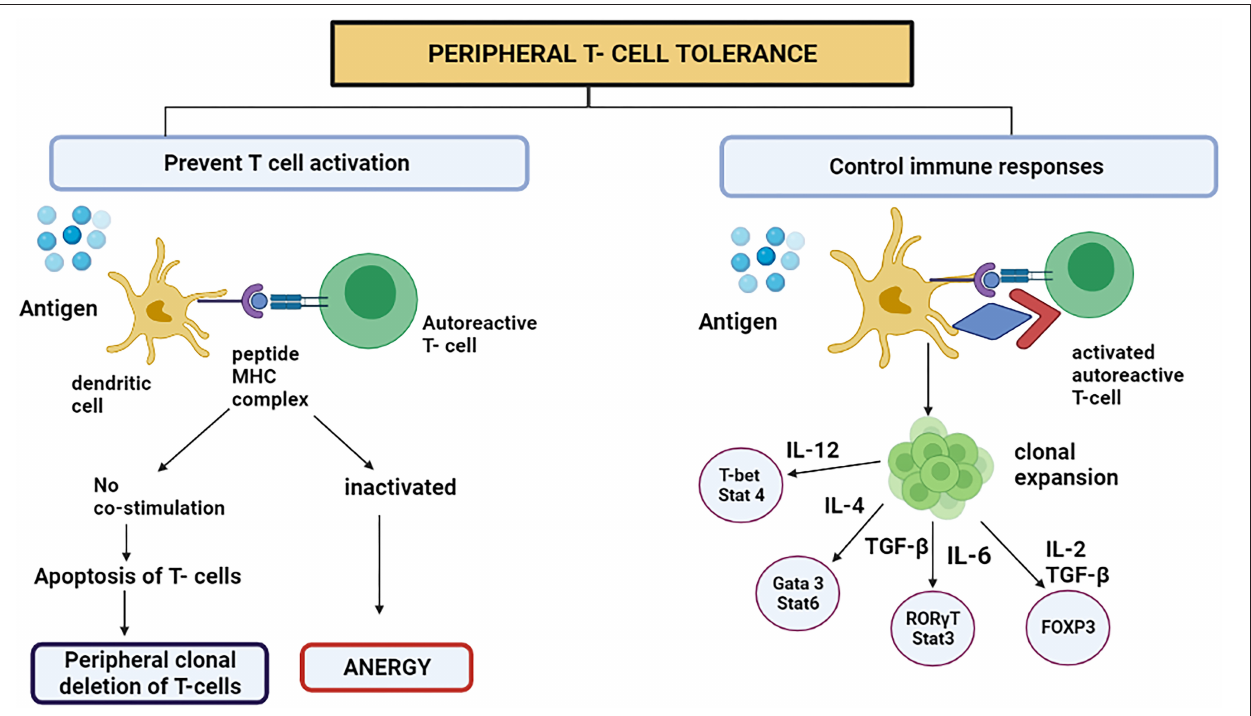
FIGURE 2 | Peripheral T cell tolerance prevents T cell activation or controls the immune responses by switching on certain signaling pathways. However, to present T cell activation, the DC representing antigen either attaches to autoreactive T cell or starts apoptosis because the stimulatory component was absent on DC. This is called peripheral clonal deletion of T cells. If the T cell is inactivated, the process is called